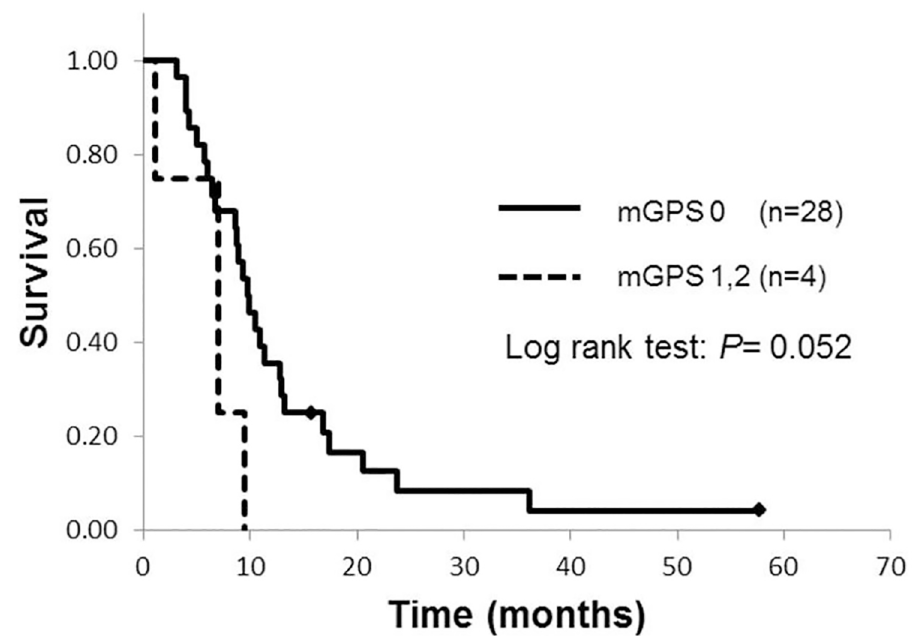
Fig 2. Kaplan-Meier curves for overall survival by mGPS values without obstructive jaundice.